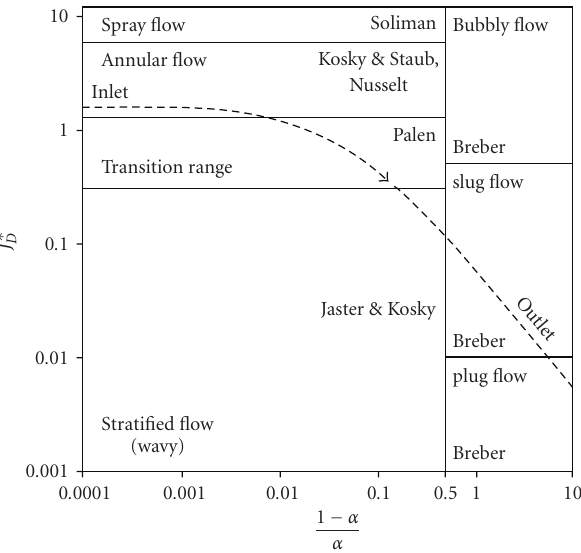
Figure 9: Tandon’s flow pattern map for condensation in a horizontal tube.